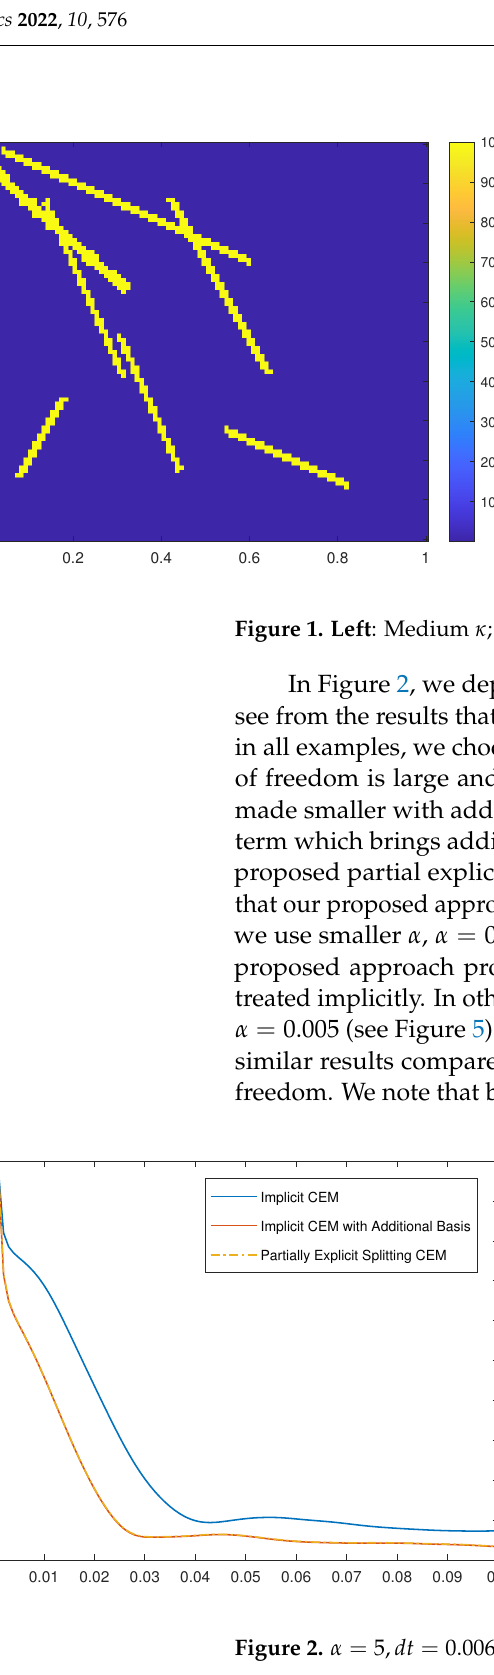
Figure 2. α = 5, dt = 0.006. Left : L 2 error. Right : Energy